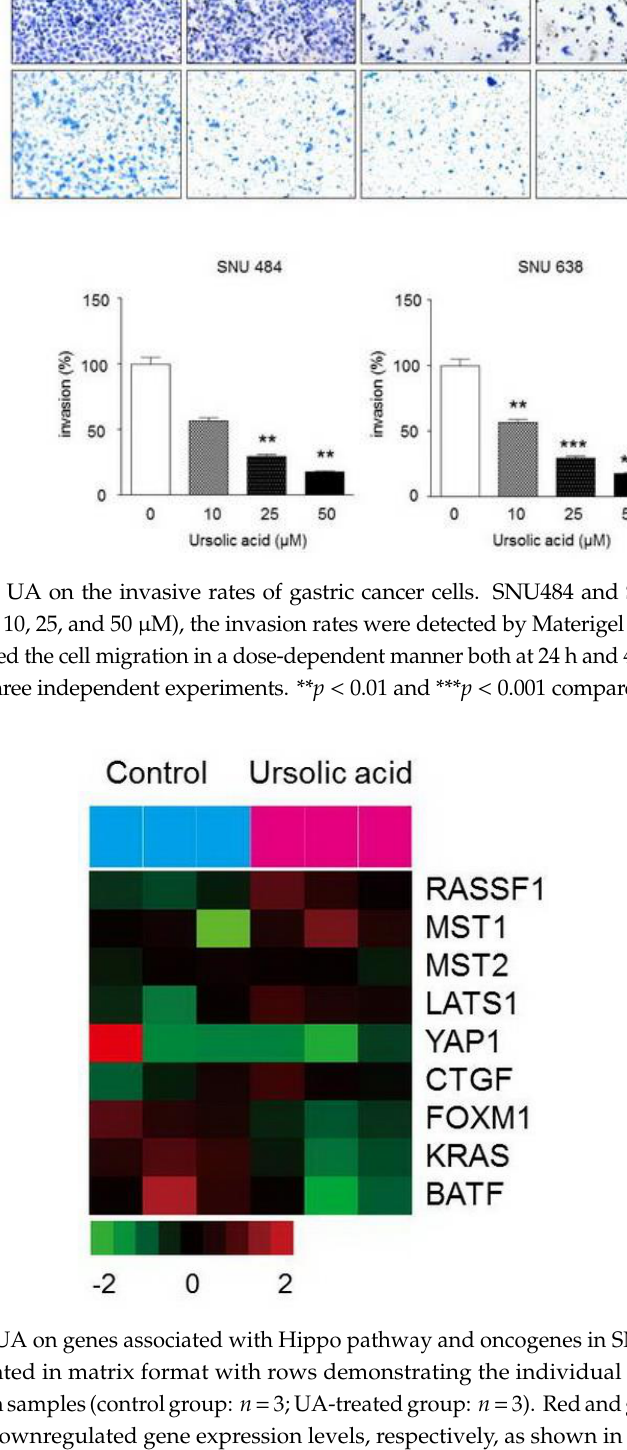
Figure 6. E ff ect of UA on genes associated with Hippo pathway and oncogenes in SNU484. Microarray heat map is presented in matrix format with rows demonstrating the individual gene and columns demonstratingeachsamples(controlgroup: n = 3; UA-treatedgroup: n = 3). Redandgreencolorindicate upregulated and downregulated gene expression levels, respectively, as shown in the scale bar (log 2 transformed). RASSF1; ras association domain-containing protein1, MST1; macrophage-stimulating 1, MST2; macrophage-stimulating 2, LATS1; large tumor suppressor kinase 1, YAP1; yes-associated protein 1, CTGF; connective tissue growth factor, FOXM1; forkhead box protein M1, KRAS; K-ras, BATF; basic leucine zipper transcription